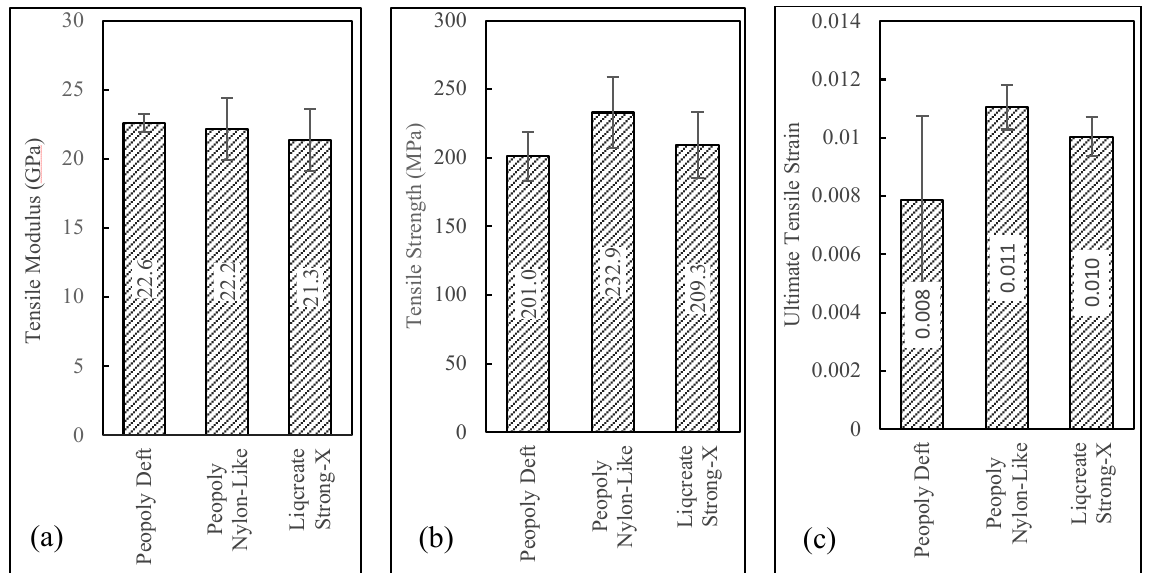
Figure 8. ( a )Tensile modulus, ( b ) tensile strength, and ( c ) ultimate tensile strain. The mechanical properties of fiber and the matrix materials control the tensile prop- erties of the 3D printed composites. The properties of the composites could be altered by varying the V f . Using the V f values from Figure 5, theoretical tensile strength and modulus were modeled by the rule of mixture (ROM) with slight modification. The cross-sectional area corrected ROM model is expressed in Equations (10) and (11). Here, σ cu , σ fu , and σ mu are the tensile strengths of the composite, fiber, and matrix, respectively. E c , E f , and E m are the tensile moduli of the composite, fiber, and matrix, respectively. In this model, the geometric factor k g was included to adjust the actual cross-sectional area that resembles the printed specimens. Figure 9 shows a comparison of experimental vs. theoretically predicted tensile